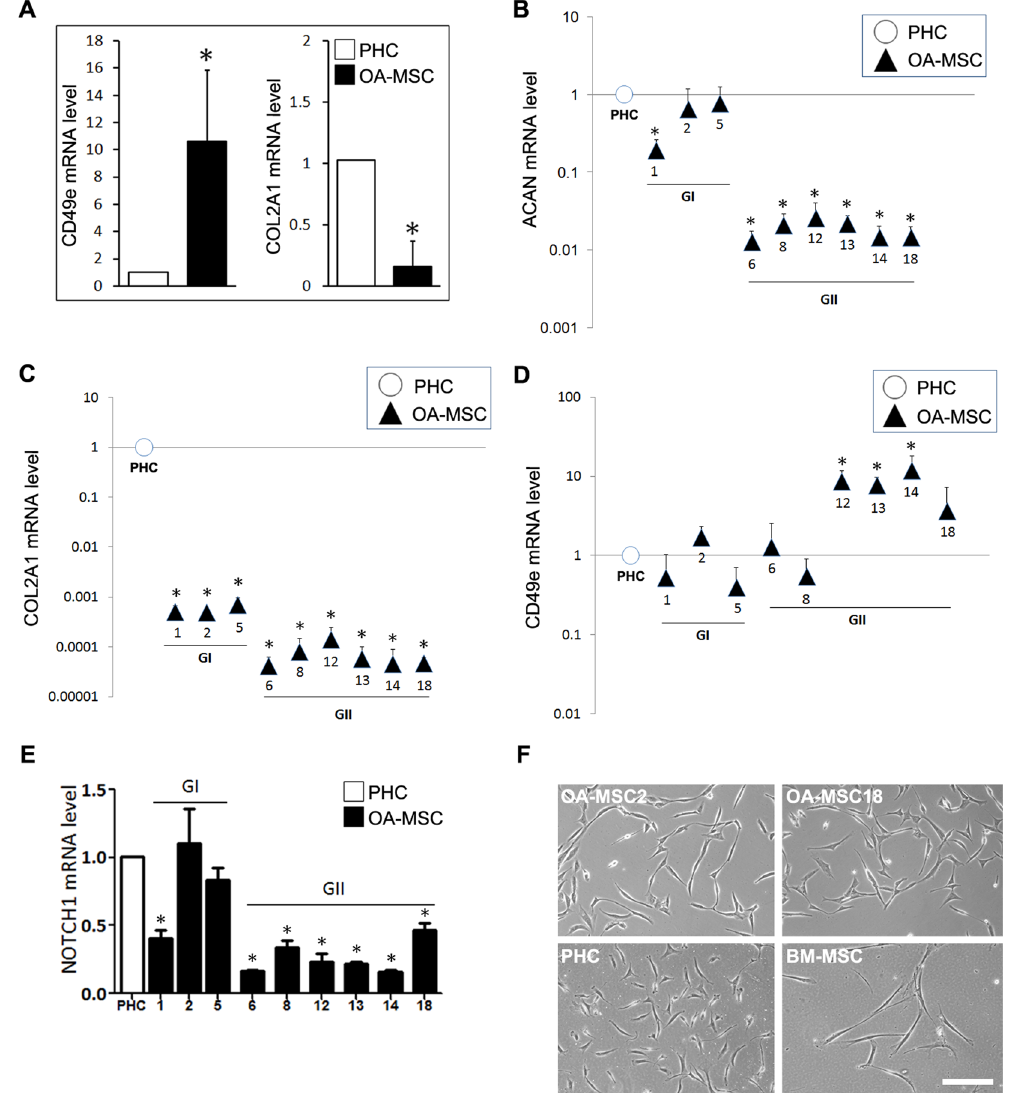
Figure 2. Gene expression and morphological analysis of human OA cartilage-derived stem cell lines. (A) Quantification of CD49e and COL2A1 mRNA levels in primary human osteoarthritis mesenchymal stem cells (OA-MSC), compared with primary human chondrocytes (PHC). (B) Relative aggrecan (ACAN), (C) type II collagen (COL2A1), (D) fibronectin receptor CD49e and (E) NOTCH1 mRNA expression levels in PHCs and nine OA-MSC lines. OA-MSC lines were categorized into two groups (GI, GII) based on their relative ACAN and COL2A1 expression levels. Due to the wide distribution of relative expression values, a logarithmic scale on the y-axis is implemented in B-D. (F) Cellular morphologies of OA-MSC2, OA-MSC18, PHCs and bone marrow derived mesenchymal stem cells (BM-MSCs). Images were acquired at an original magnification of 10 × using an inverted microscope, Scale bar represents 100 µ m. For all quantitative data, n ≥ 3. * p ≤ 0.05; ** p ≤ 0.01, relative to PHCs. Quantitative data are represented as mean ±